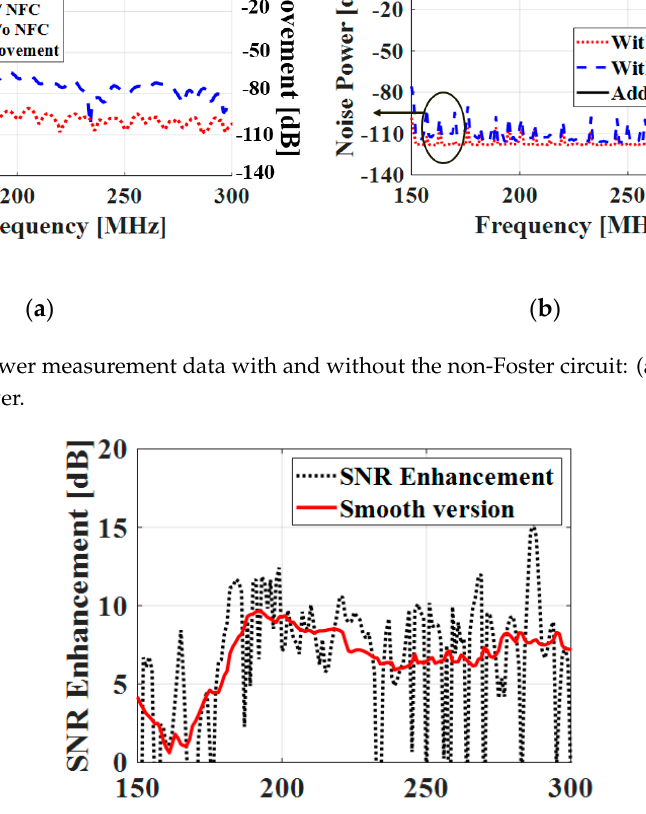
Figure 11. Signal-to-Noise Ratio enhancement due to the non-Foster circuit.